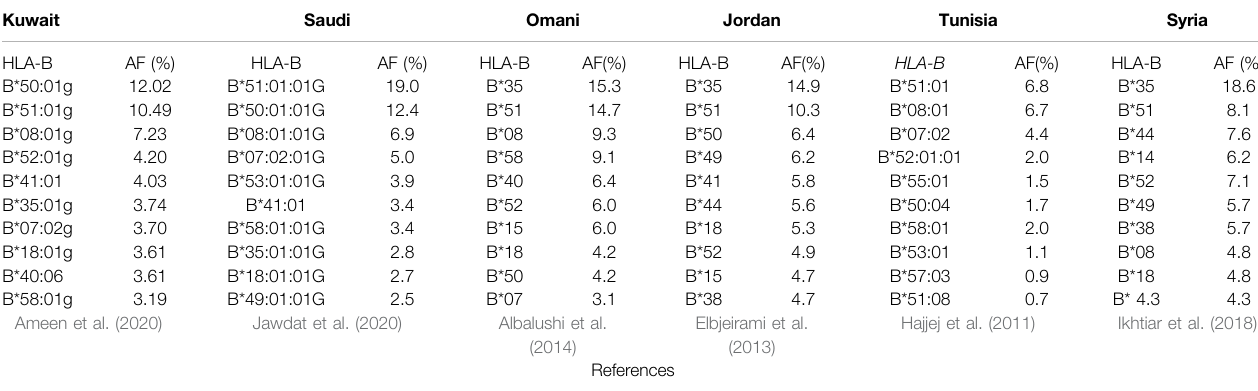
TABLE 1 | Top 10 HLA-B frequent alleles in the Arab